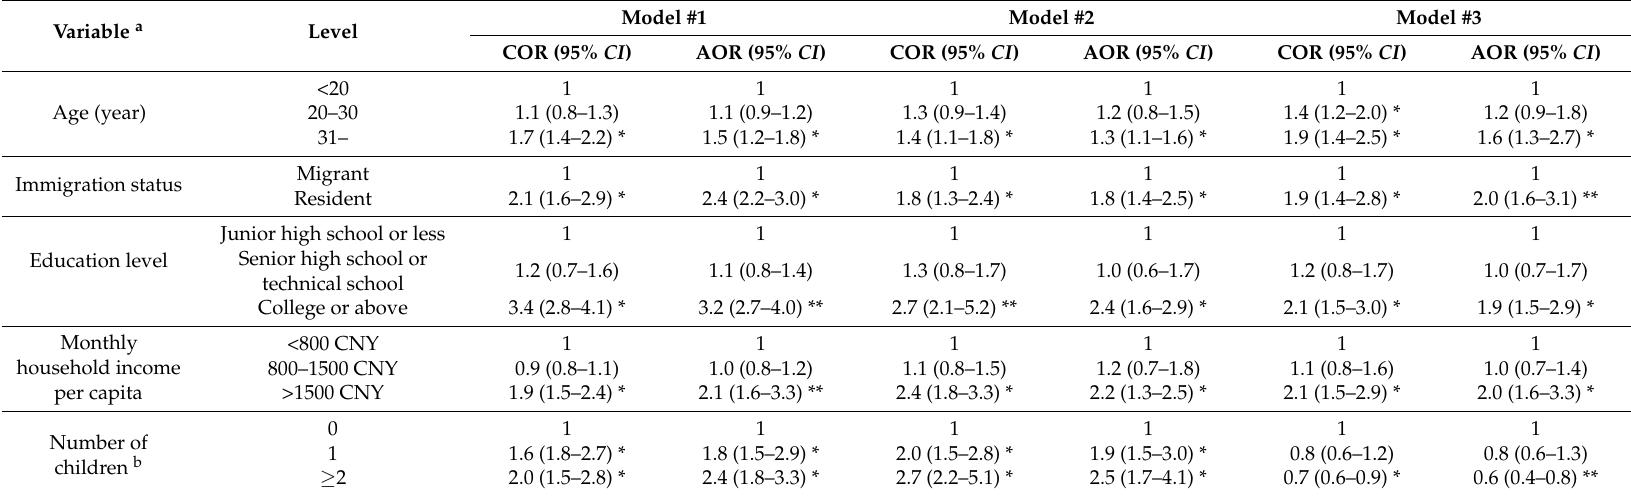
Table 3. Univariable and multivariable analysis indicating associations between several variables and outcomes regarding vaccination against varicella